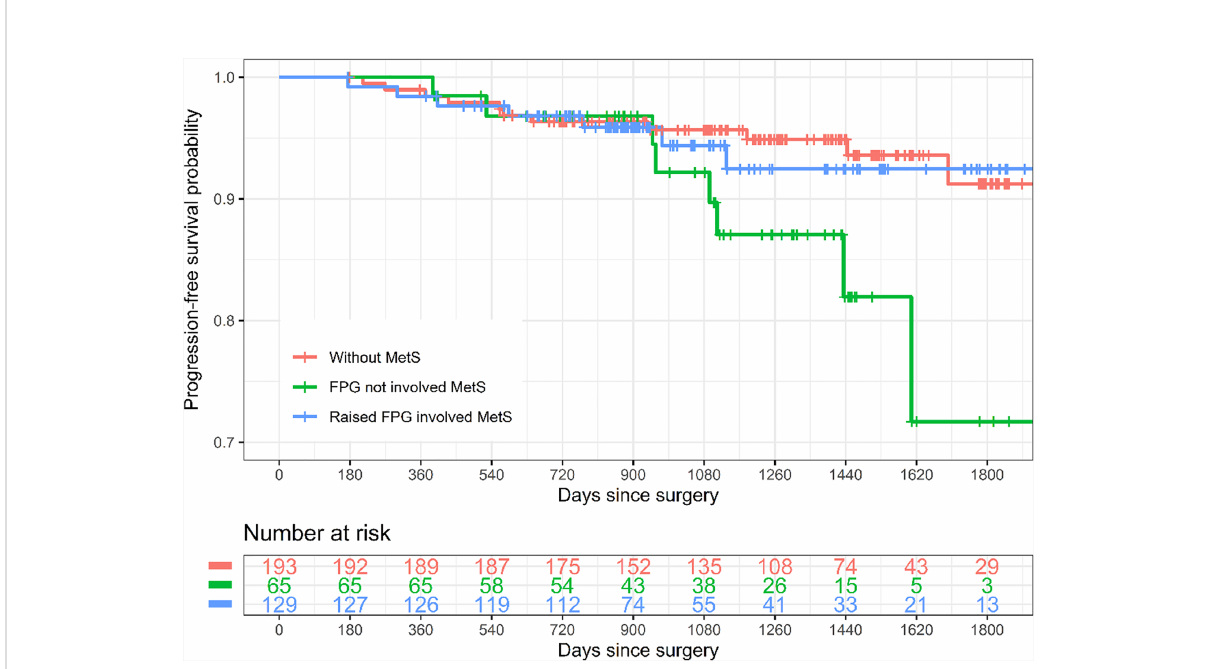
FIGURE 2 Kaplan – Meier curves of progression-free survival by subtypes of metabolic syndrome. Raised FPG involved MetS refers to MetS diagnosed according to the new International Diabetes Federation (IDF) de fi nition and the patients were with the factor “ raised FPG ” which were determined by FPG ≥ 5.6 mmol/l and/or HbA1c ≥ 6.5%. The rest of the MetS patients were categorized as FPG not involving MetS. MetS, metabolic syndrome; FPG, fasting plasma